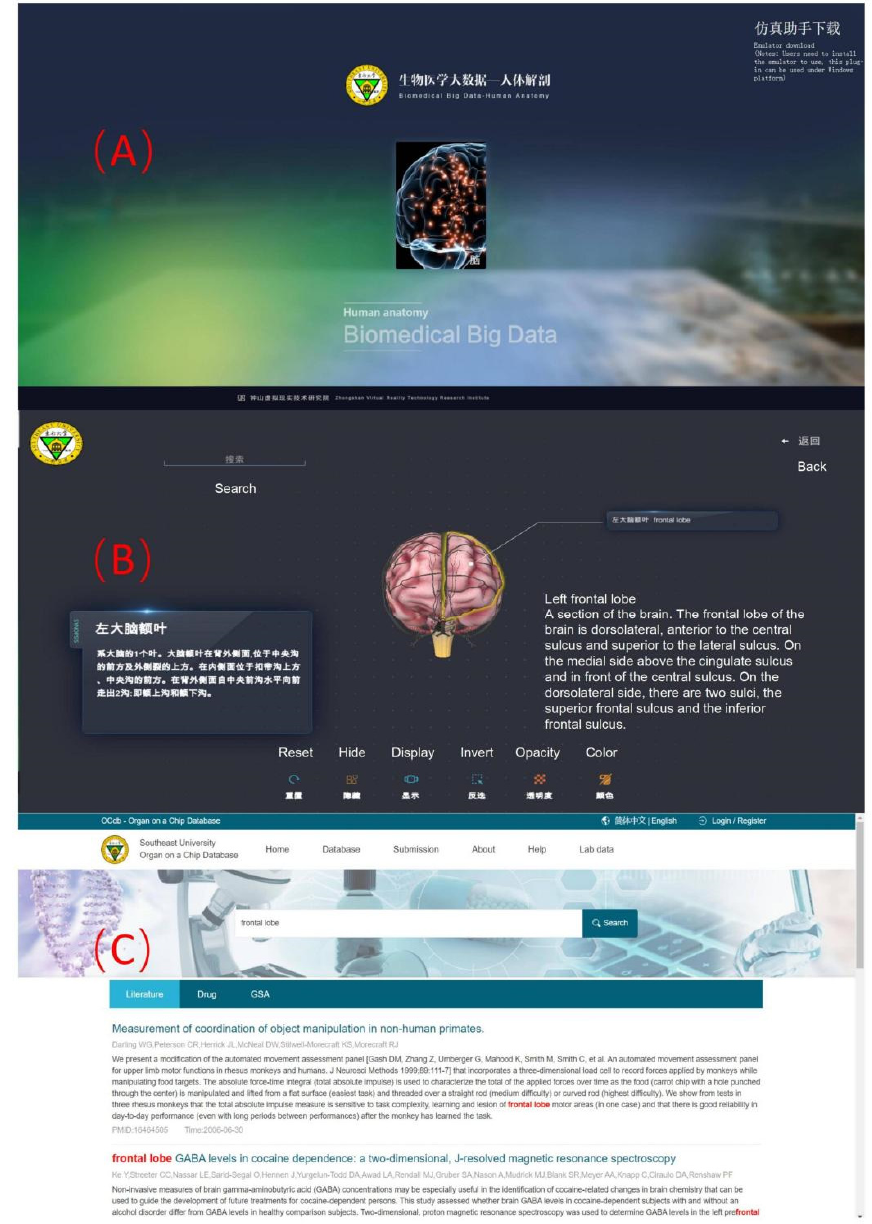
Figure 6. Web pages of the 3D brain structure study resource. ( A ). Welcome page of the 3D brain structure resource interface. ( B ). A high-quality 3D brain anatomy model. The user can rotate this